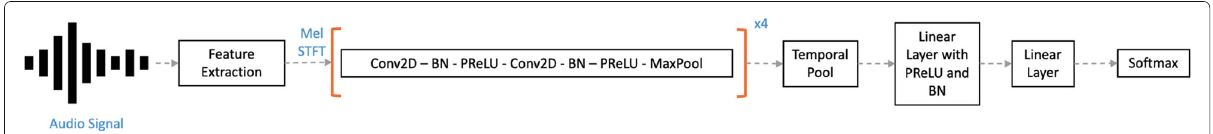
Fig. 2 Network architecture of our Audio Classification model. The network takes in 2 s audio clips sampled at 48 kHz as input and extracts log mel spectrogram as input. The spectrogram is passed as an input to the VGGish network consisting of 4 convolutional blocks. Each block consists of conv2D-BatchNorm(BN)-PReLU-conv2D-BN-PReLU and a 2 × 2 MaxPool2D layer. Following the blocks, we pool along the temporal axis and reshape the input into a 2D array. This input is passed through two fully connected layers of sizes 512 (with a dropout of 0.5) and 121 respectively. Finally, we perform a softmax on 121